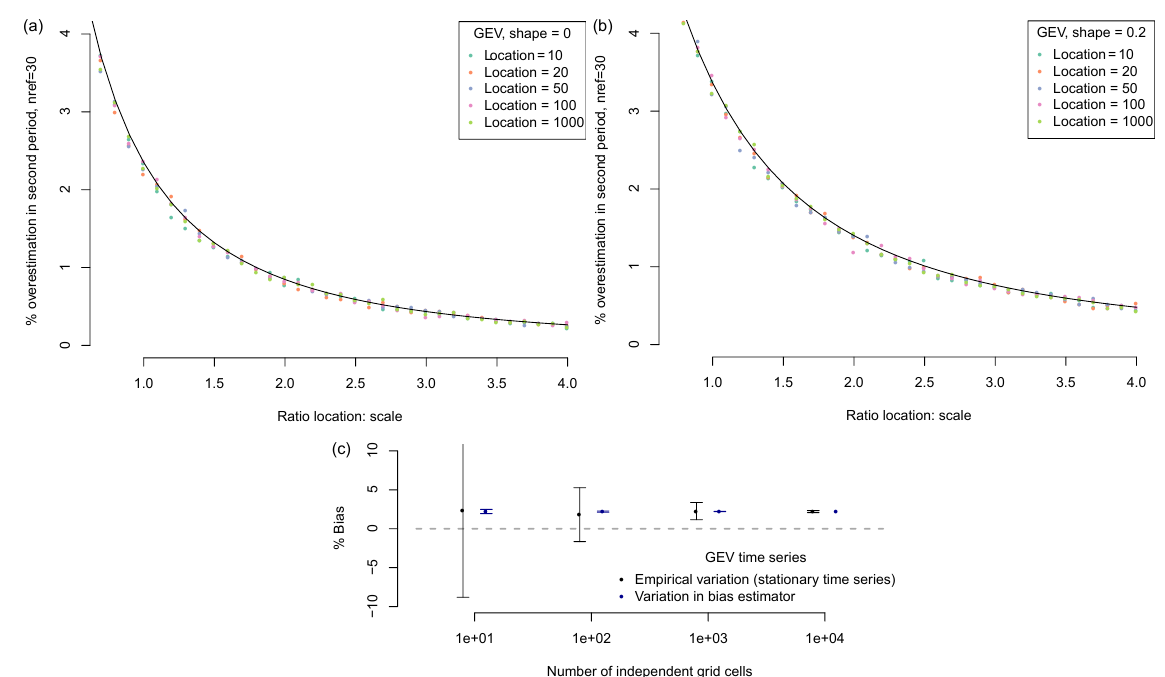
Figure A2. (a) Ratio of location to scale parameter vs. normalization-induced bias in a GEV distribution for the analytical approxima- tion (black line) and numerical simulations with various location parameter values (dots), with (a) zero shape parameter, and (b) ξ = 0.2. Reference period length is taken as n ref = 30, and numerical simulations are conducted with n = 10 5 grid cells with each 60 time steps. (c) Analytical estimates of biases as calculated from sample mean and sample standard deviation following Eq. (1) in the main text (dark blue) for a given number of independent grid cells drawn from a GEV distribution ( µ of random changes in stationary time series (i.e. empirical variation in the quantity (cid:49) bias , following Eq. A1) with n ref = 30 and n obase = 30 is shown in black. Error bars indicate the 5th to 95th percentile in repeated numerical